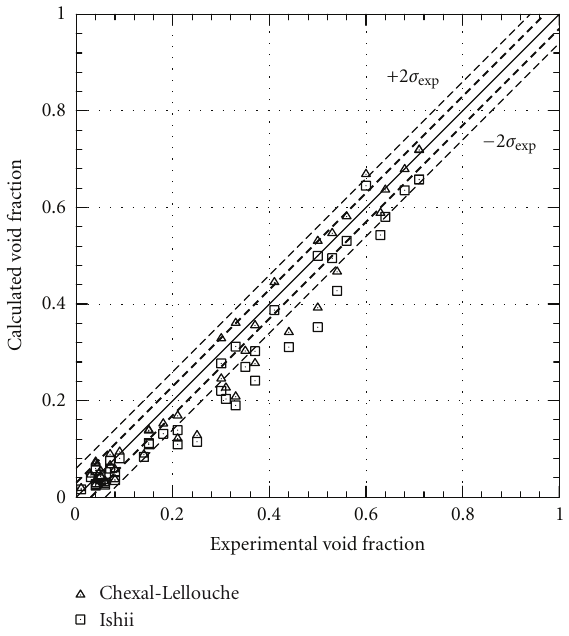
Figure 1: Comparison of void fractions predicted by the Chexal- Lellouche and the Ishii drift correlations against experimental data (subchannel S1